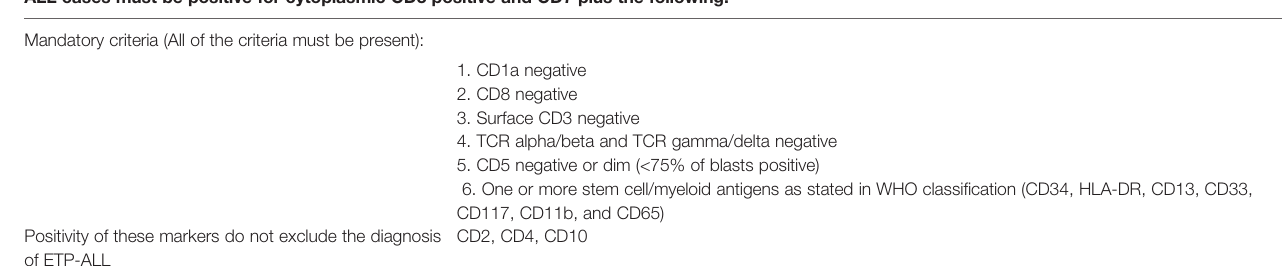
TABLE 5 | Suggested diagnostic criteria for ETP-ALL. ALL cases must be positive for cytoplasmic CD3 positive and CD7 plus the following: Mandatory criteria (All of the criteria must be